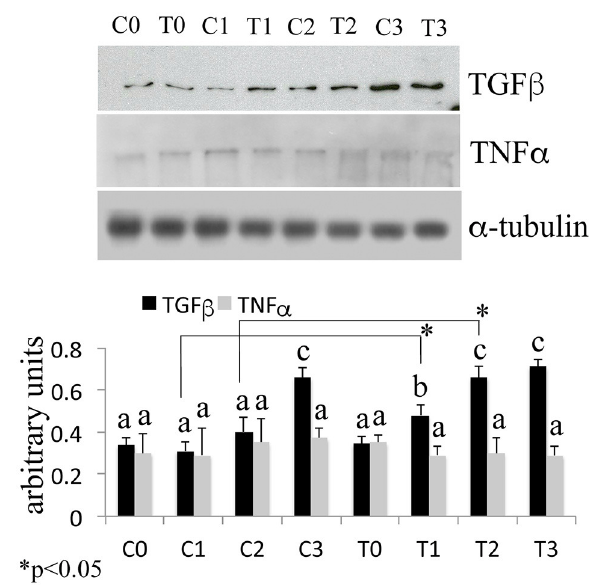
FIGURE 4 | Time-course effects of laser irradiation on TGF- β 1 and TNF α synthesis in BMSCs by western blotting analysis. Cells were laser irradiated over different periods of time (Day 0: T0; 5 days: T1; 10 days: T2; 15 days: T3). Control cultures (Day 0: C0; 5 days: C1; 10 days: C2; 15 days: C3) were maintained in identical conditions except that the laser device was switched off. At the end of each treatment, proteins from BMSCs irradiated and untreated were extracted, subjected to SDS-PAGE, transferred to a PVDF membrane, and probed with rabbit anti-TGF- β 1 rabbit anti-TNF α ; then, filters were stripped and re-probed mouse anti- α -tubulin antibody to show equal amount of loading. Graphic represents results of three independent experiments. Data were analyzed by using one-way ANOVA. Lowercase letters denote homogeneous subsets. Error bars represent ± SE (* p <